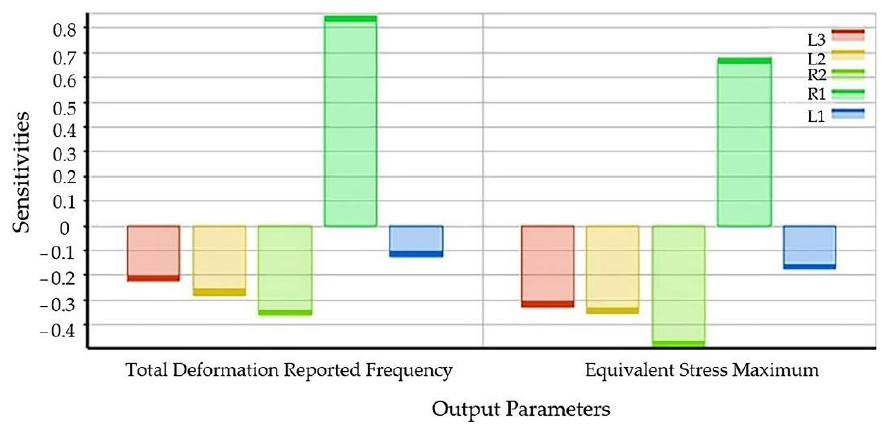
Figure 10. Sensitivity diagram of sample size to analysis